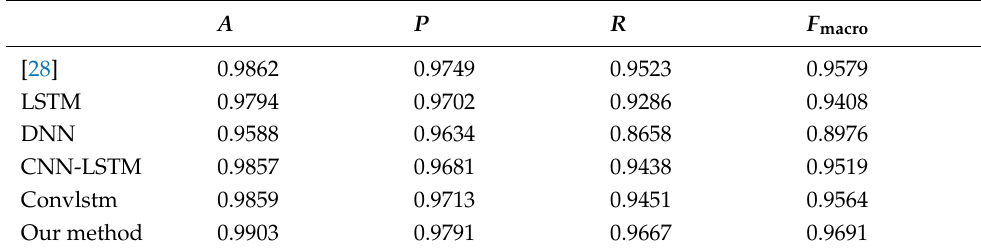
Table 3. Comparison of results of different neural networks in single-point open-circuit fault localization.